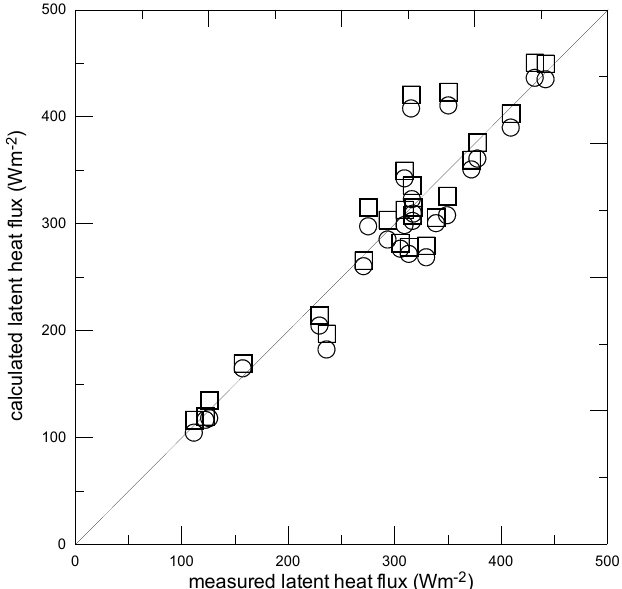
Figure 5. Test for the latent heat flux calculated by the PM model with the calibrated parameters, versus the latent heat flux estimated by the measured surface energy budget (squares: Level 3, circles: Level 5).